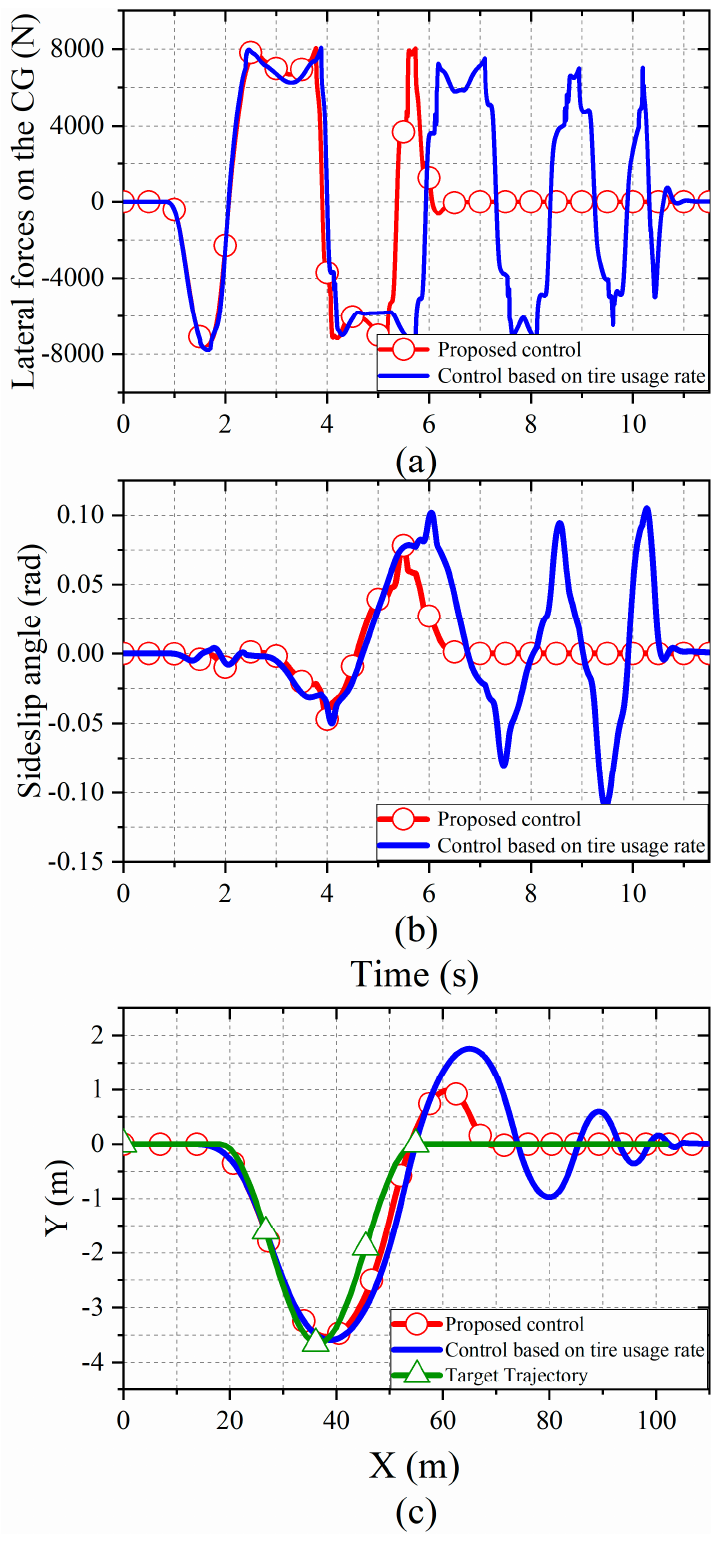
Figure 8. Comparison of the vehicles using the proposed control and the optimal tire usage rate control: (a) CG lateral force; (b) sideslip angle responses; (c) vehicle trajectory. control: ( a ) CG lateral force; ( b ) sideslip angle responses; ( c ) vehicle